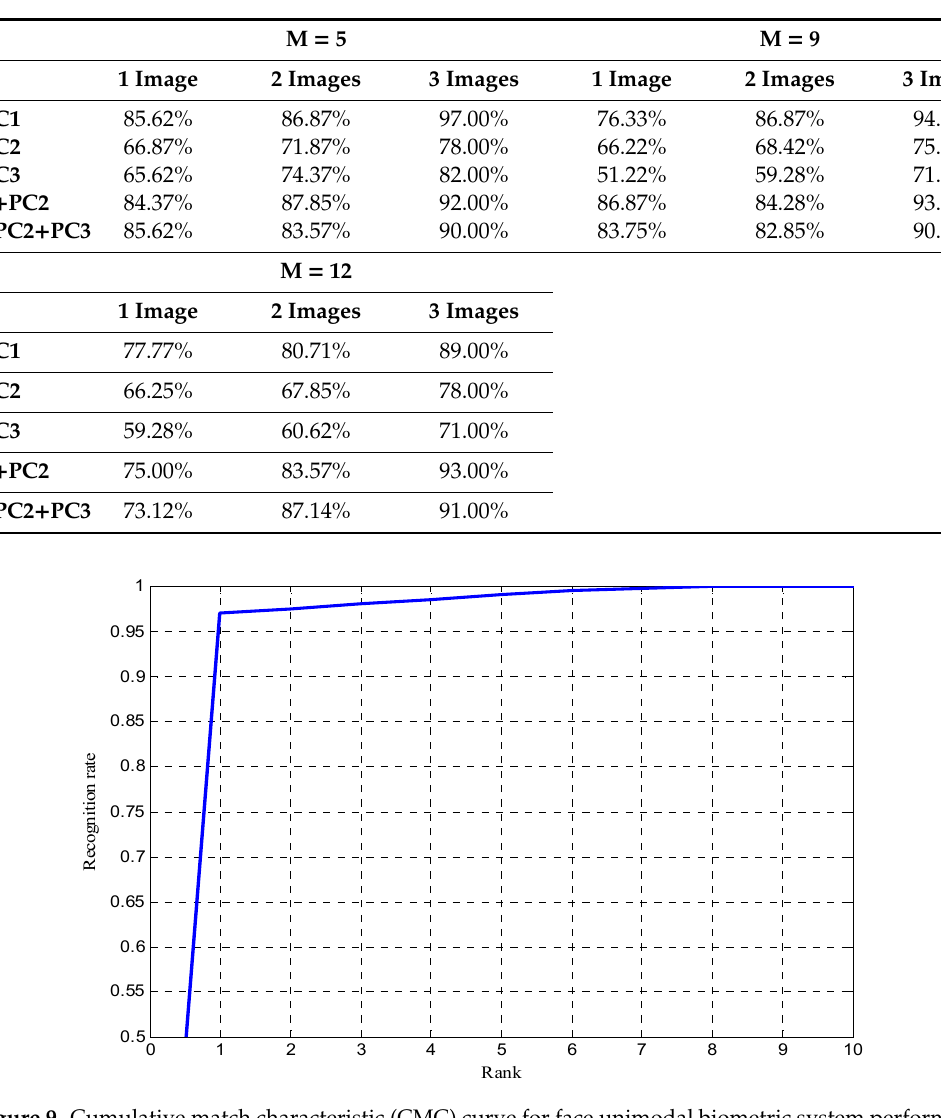
Table 3. Recognition rate of the face unimodal biometric system performed on the ORL face database.